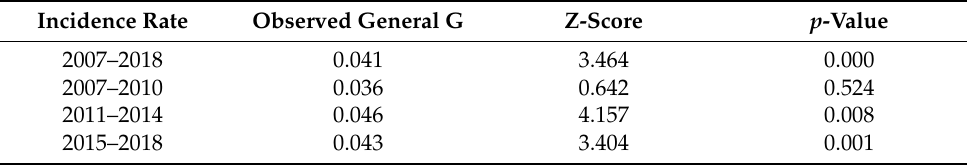
Table 2. Getis–Ord General G spatial association analysis of HIV infection and AIDS incidence rates in Belém, PA, Brazil (2007–2018).